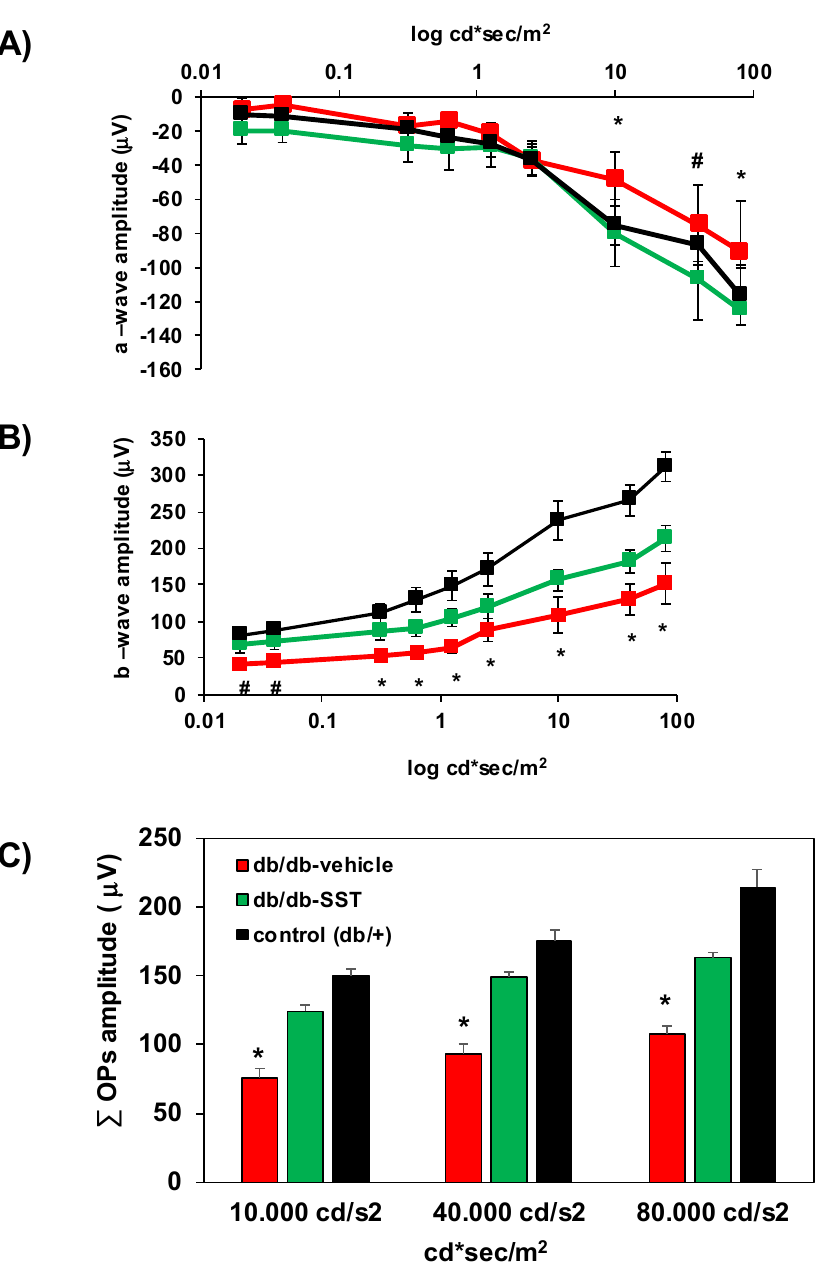
Figure 4. Effect of topical administration of SST on electroretinography (ERG) abnormalities in db/db mice. ( A ) Quantitative analysis of the amplitude of a -wave in db/db treated with vehicle (n = 10, red color), db/db treated with SST (n = 10, green color) and non-diabetic mice (n = 10, black color). ( B ) Amplitude of b -wave in db/db treated with vehicle (n = 10, red color), db/db treated with SST (n = 10, green color) and non-diabetic mice (n = 10, black color). ( C ) Oscillatory potentials (OPs) amplitude in the experimental groups. The first five OPs have been added up in performing this quantification. Results are mean ± SEM. * p < 0.05 (db/db treated with vehicle vs. the other groups). # p < 0.05 (db/db treated with vehicle vs. non-diabetic mice).